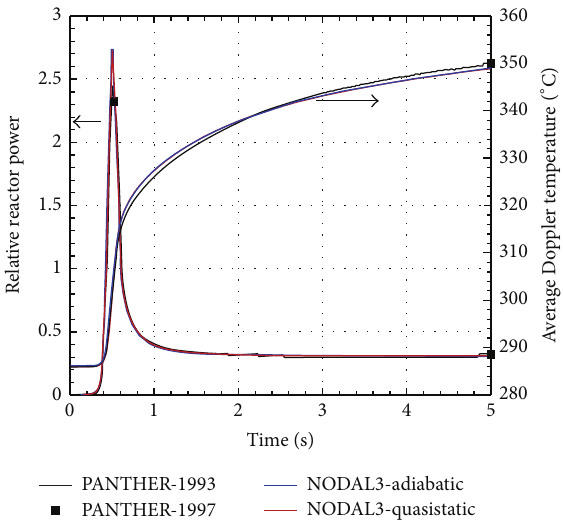
Figure 6: Comparison between NODAL3 and references results for case A1.